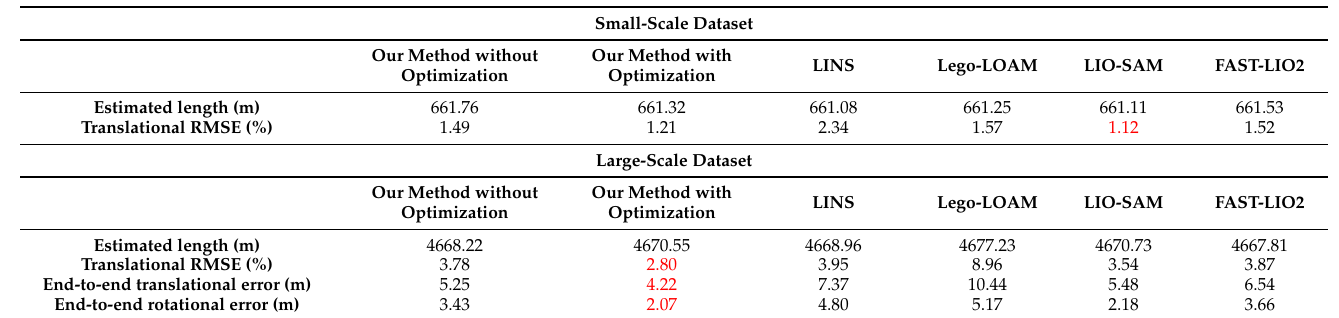
Table 1. Accuracy evaluation of the trajectories estimated by different methods and LIO systems in open dataset.